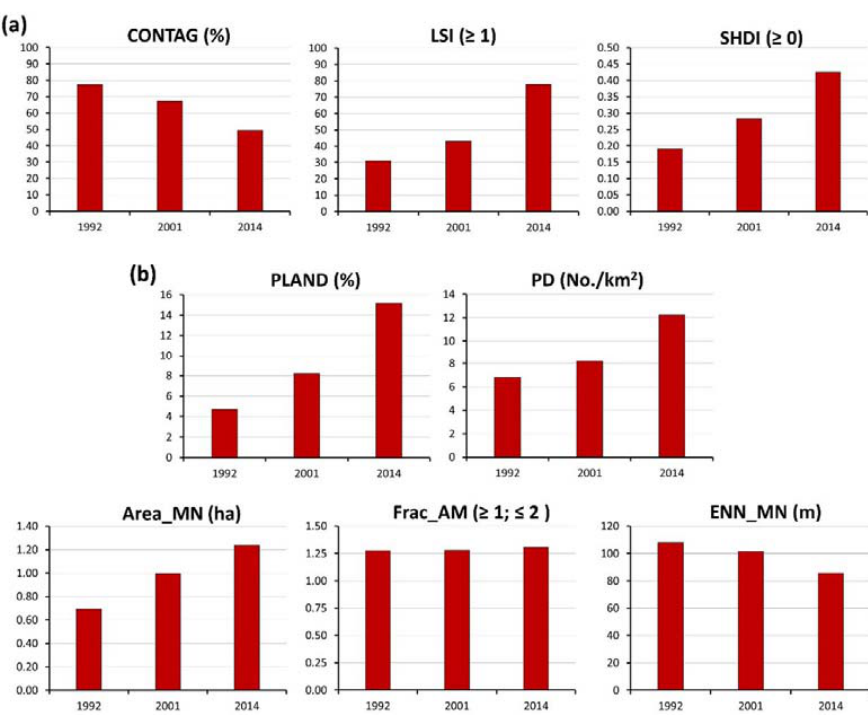
Figure 5. Spatial metrics at the ( a ) landscape level; and ( b ) class level (built class). Note: CONTAG, contagion index; LSI, landscape shape index; SHDI, Shannon’s diversity index; PLANP, percentage of landscape; PD, path density; Area_MN, mean patch size; Frac_AM, area-weighted mean patch fractal dimension; and ENN_MN, mean Euclidean nearest neighbor distance.